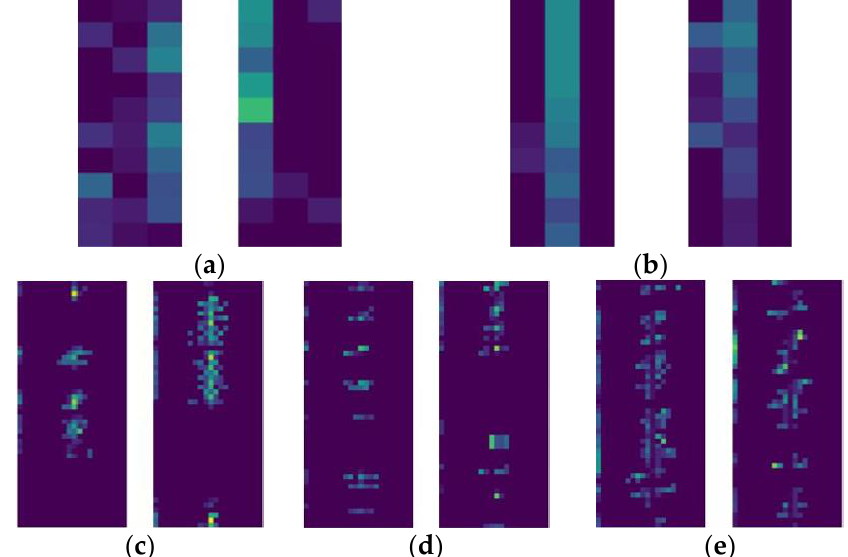
Figure 2. Examples of image-like representations of sensor measurements for different driving behaviours: ( a ) 50 × 3 image for normal driving behaviour in UAH dataset, ( b ) 50 × 3 image for aggressive driving behaviour in UAH dataset, ( c ) 50 × 22 image for normal driving behaviour in MOTIF 1 dataset, ( d ) 50 × 22 image for semi-aggressive driving behaviour in MOTIF 1 dataset, ( e ) 50 × 22 image for aggressive driving behaviour in MOTIF 1 dataset.